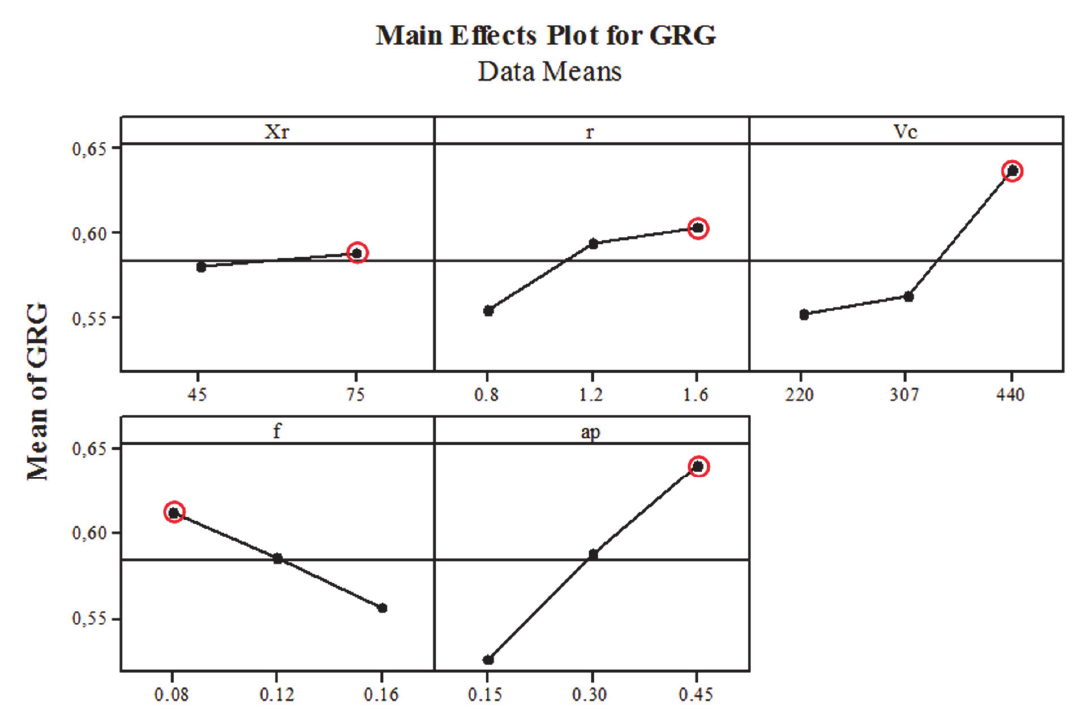
Fig. 11. Main effect’s plots for GRG